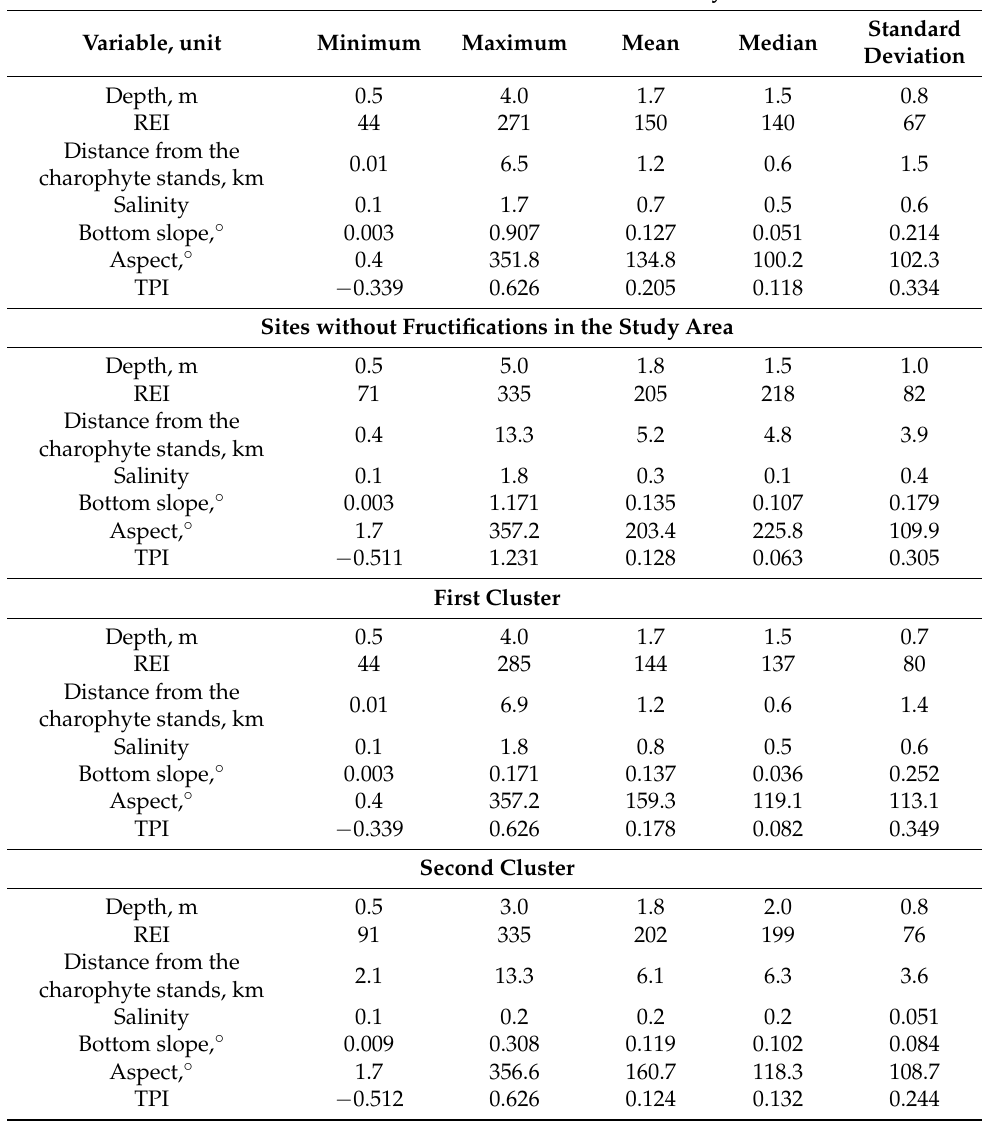
Table 2. The statistics of environmental variables in the sites with presence and absence of charophyte fructifications, and in the two clusters delineated in the cluster analysis (Figure 3). Sites with Presence of Fructifications in the Study Area Variable, unit